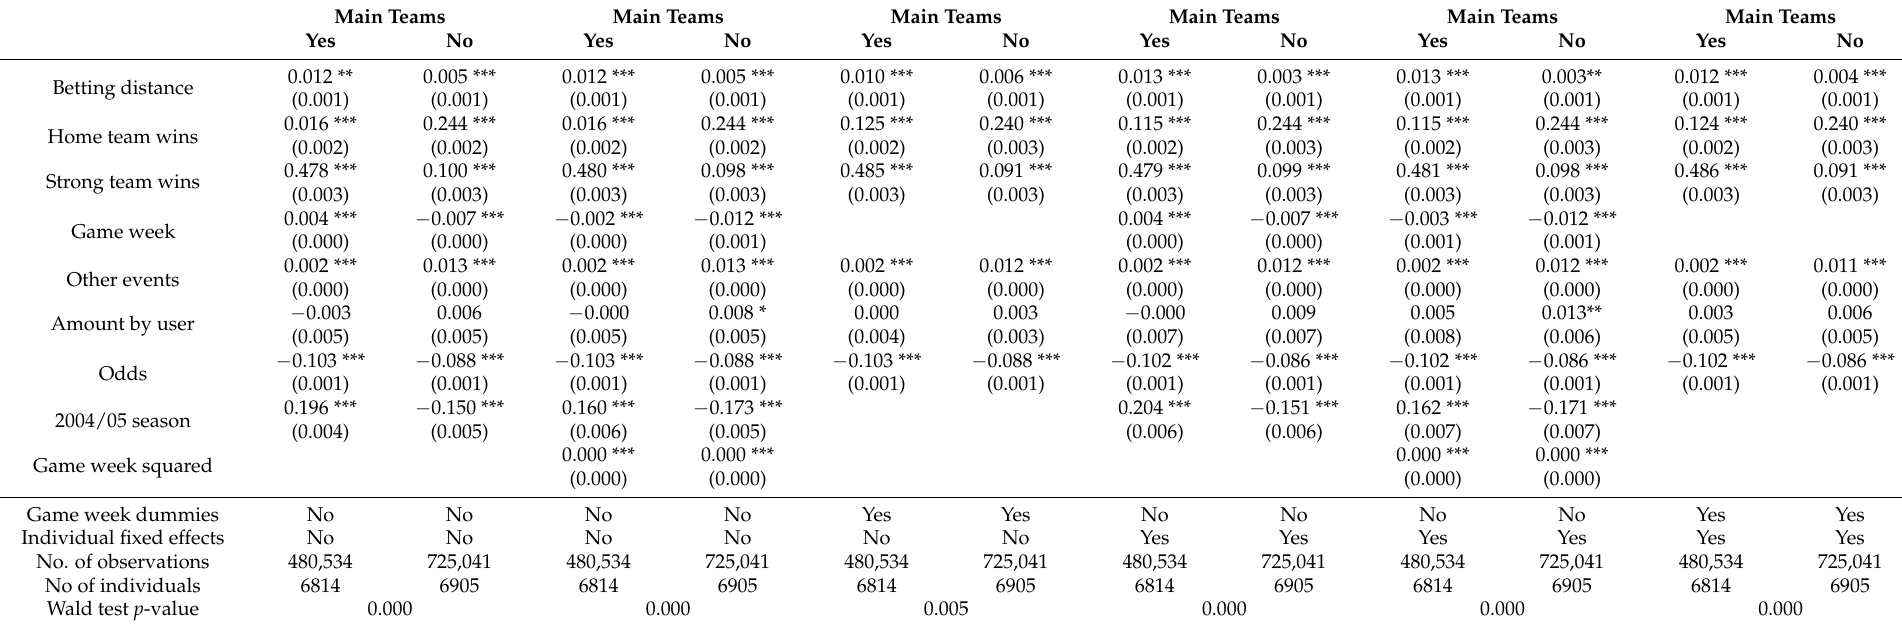
Table 1. Heterogeneity: main teams vs.